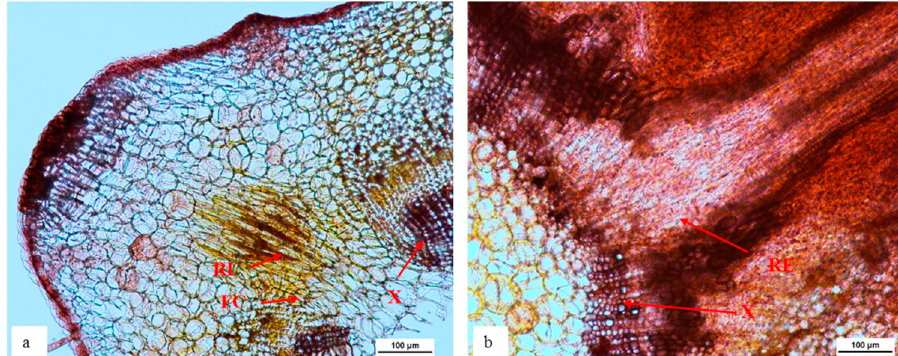
Figure 3. The root initial starting to form from the outer boundary of xylem and thick fascicular cambium layer ( a ) and extend outwards through the phloem ( b ) of stem in in vitro cultured ‘Reed’ during rooting. Transverse stem sections 4 weeks after rooting treatment from the base of stem tissue. Stems were embedded in agar, sectioned at 50 µm, cleared with chloral hydrate and stained with Safranin O ( n = 5). FC = fascicular cambium, RI = root initial, RE = root extension, X = xylem.